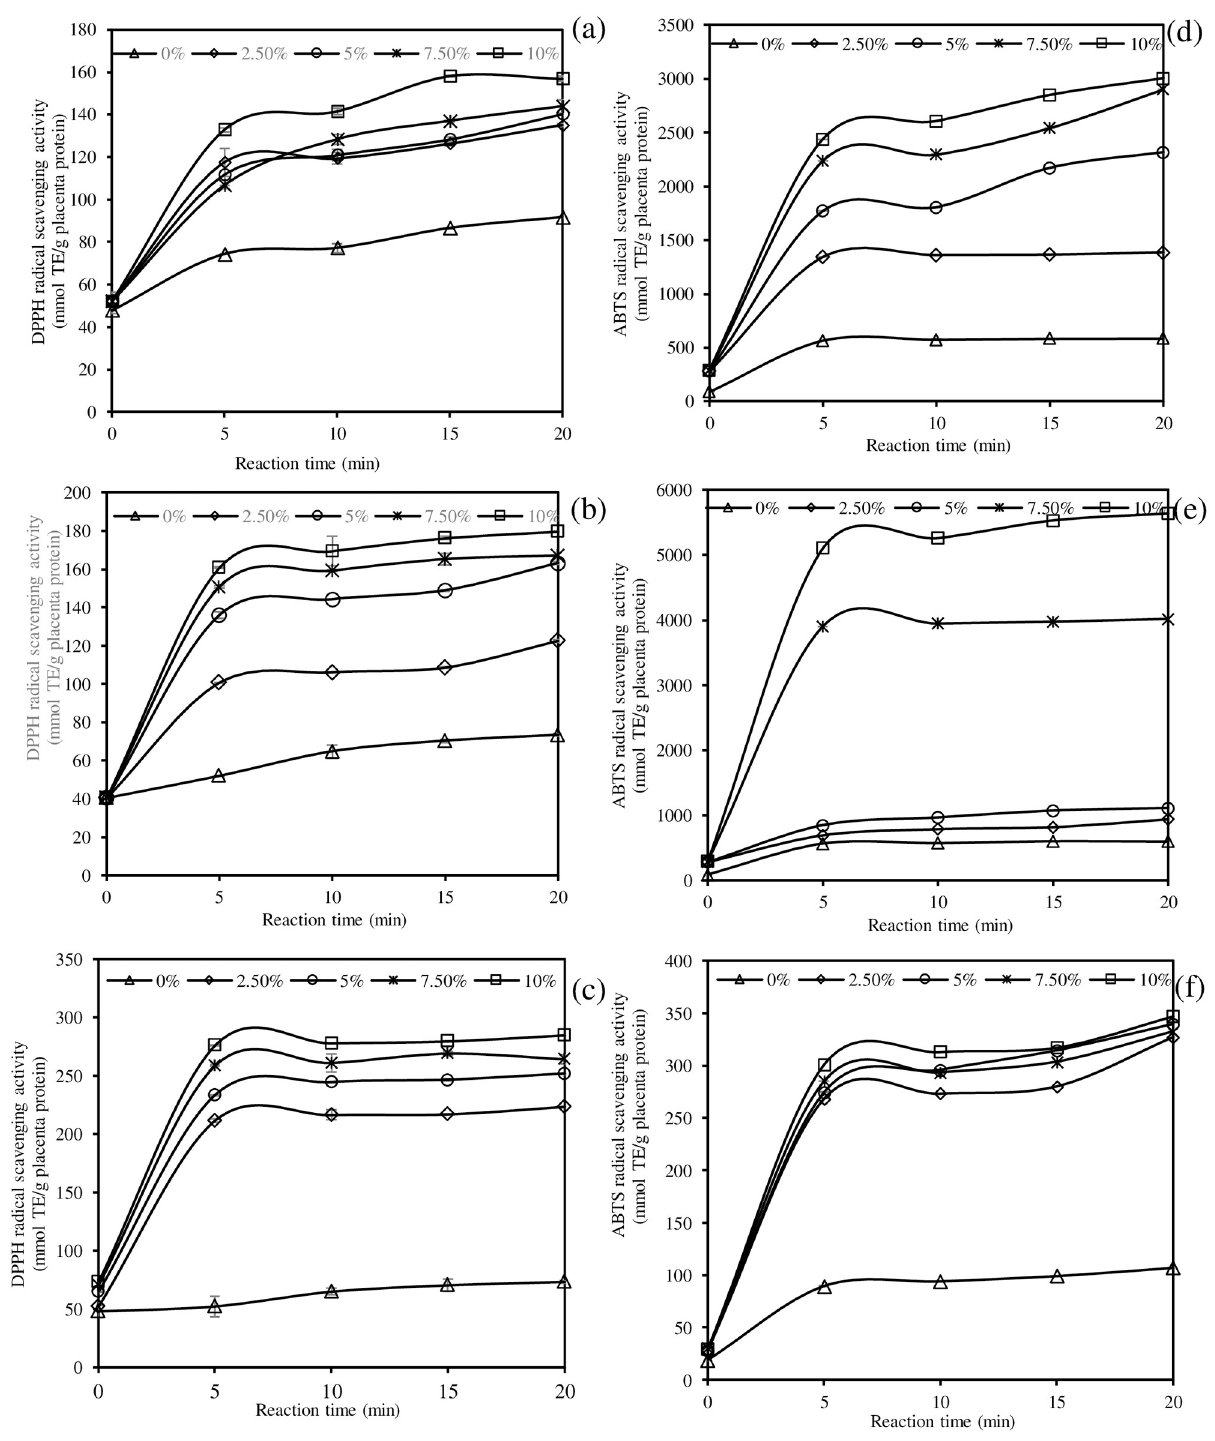
Fig 2. Effects of enzyme type (Alcalase (a, d), Flavourzyme (b, e), and papain (c, f)), enzyme concentration, and hydrolysis time on the DPPH • scavenging activity (a, b, c) and ABTS •+ scavenging activity (d, e, f) of porcine placenta hydrolysate (PPH). Bars represent standard deviation from triplicate determinations. TE = trolox